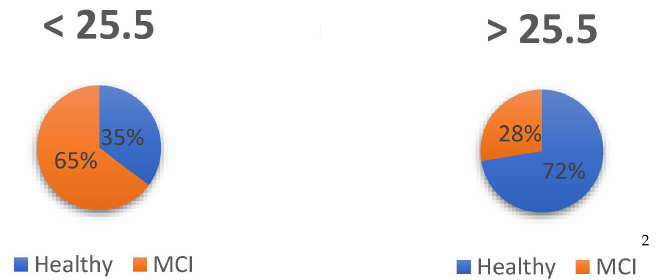
Figure 3. Assignment of subjects: Healthy and MCI. 2 The assignment of subjects was done according to diagnosis and cut-off